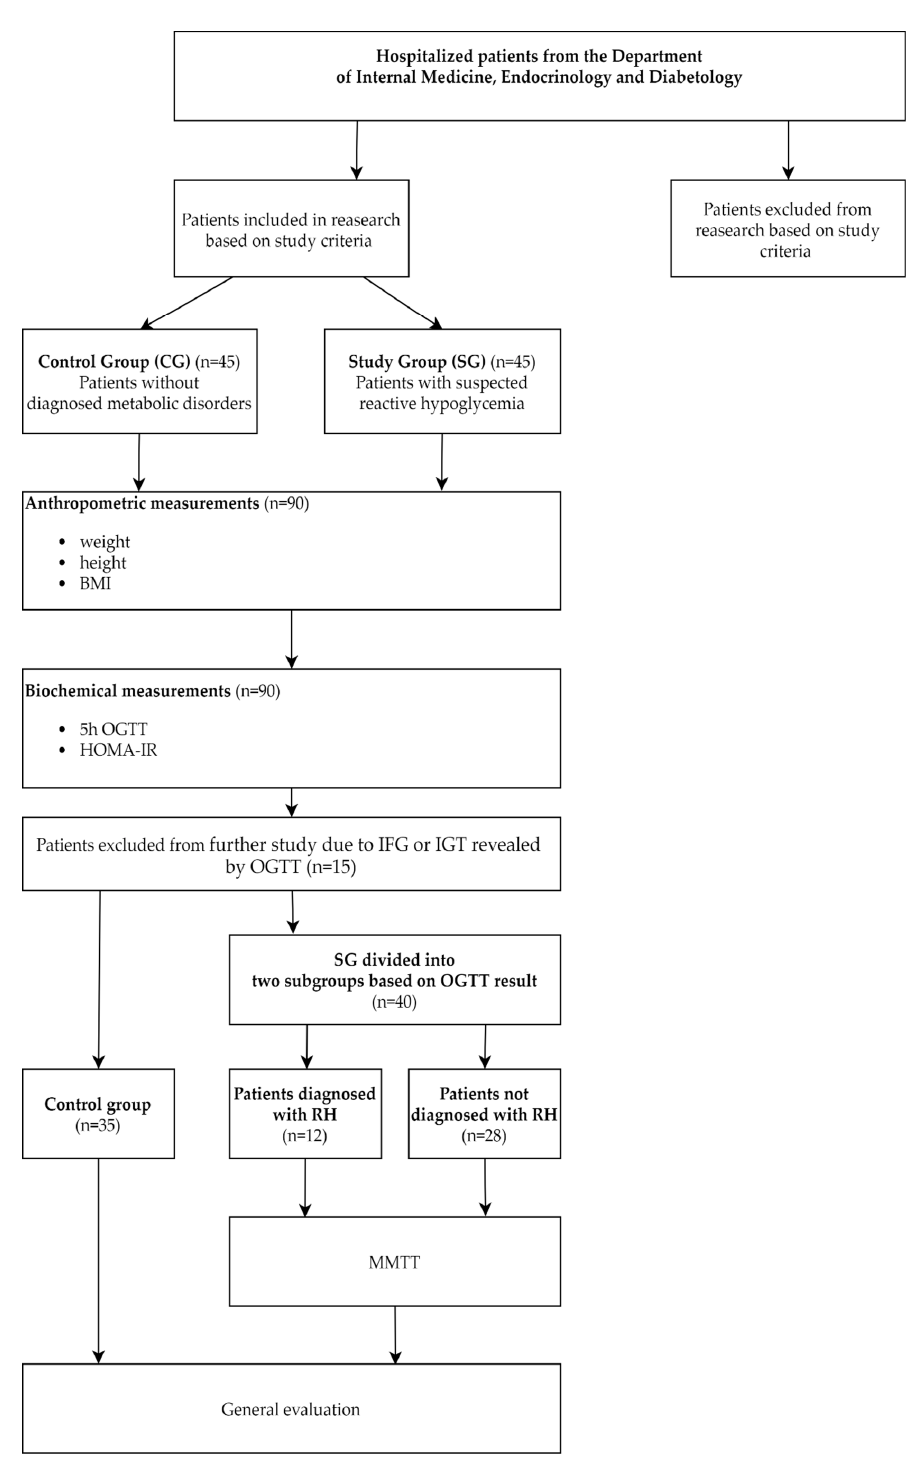
Figure 1. Performed procedures. BMI—Body Mass Index; OGTT—Oral Glucose Tolerance Test; HOMA-IR—Homeostatic Model Assessment for Insulin Resistance; IFG—Impaired Fasting Glycemia; IGT—Impaired Glucose Tolerance; RH—Reactive Hypoglycemia; MMTT—Mixed Meal Tolerance Test .